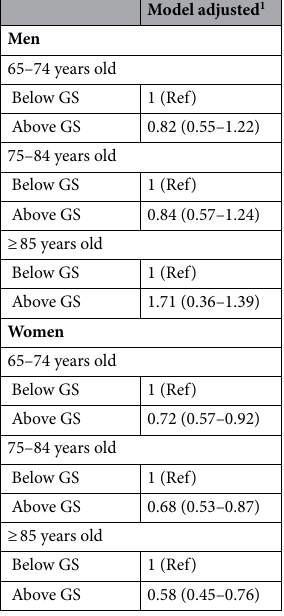
Table 3. The odds ratio for having depression symptoms according to being below or above the GS cutoff value for men and women among age groups. 1 Analysis were adjusted to sex, age, education level, chronic disease, BMI, physical activity and country. GS grip